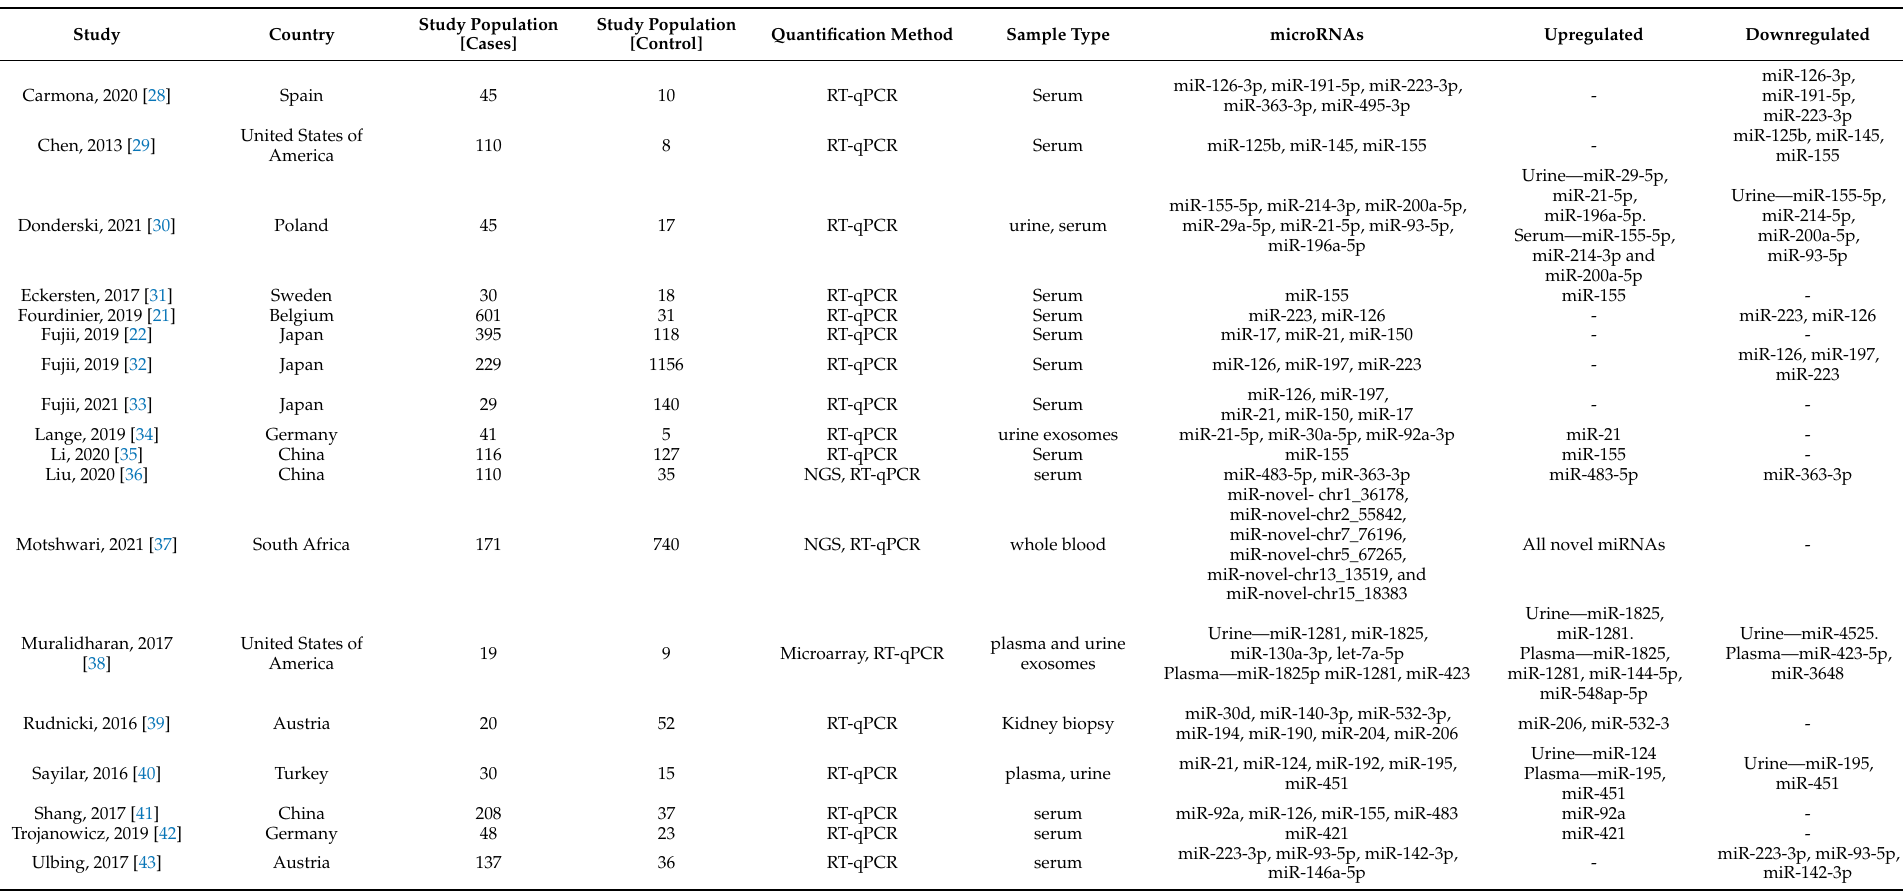
Table 1. Characteristics of studies evaluating microRNA expression patterns in chronic kidney